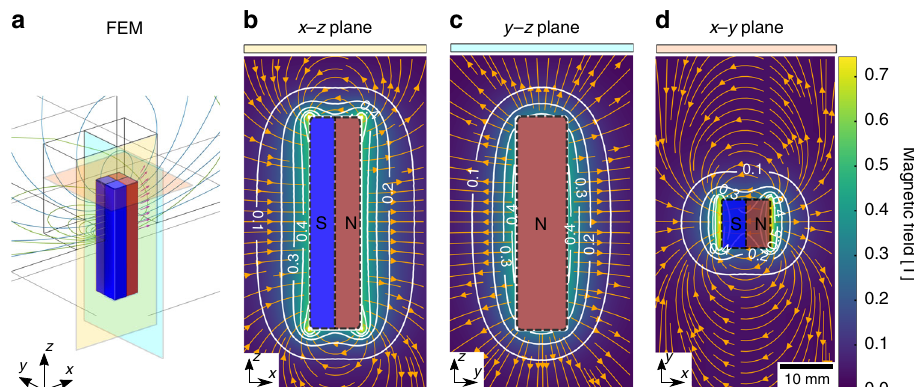
Fig. 6 Inhomogeneous and anisotropic magnetic fi eld simulations. a Rectangular cuboid neodymium permanent magnet characterization by three- dimensional (3D) fi nite element method (FEM) simulation of the magnetic fi eld distribution, the three color-coded surfaces (yellow, light blue and red) represent the cross-section planes of the streamline plot. b x – z plane projection (yellow plane) of the magnetic fi eld. c y – z plane projection (light blue plane) of the magnetic fi eld. d x – y plane projection (red plane) of the magnetic fi eld. The color code refers to the magnetic fi eld vector ’ s